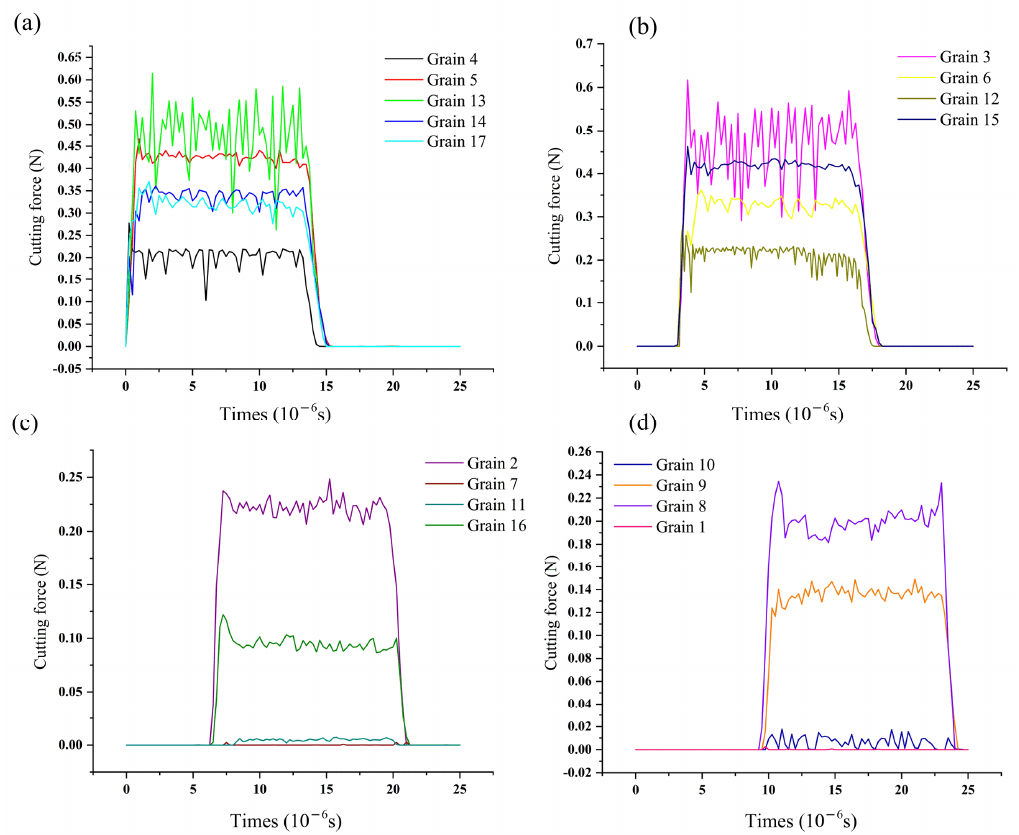
Figure 9. Honing force of single abrasive grains distributed in different rows. ( a ) The first row; ( b ) The second row; ( c ) The third row; ( d ) The fourth row.